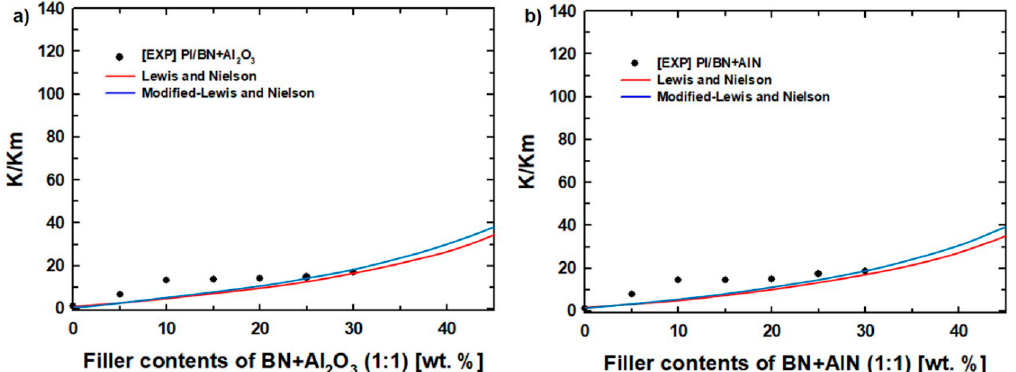
Figure 5. Experimental and theoretical thermal conductivity obtained for the ( a ) PI/BN+Al 2 O 3 and ( b ) PI/BN+AlN composites by using the additive approach model.